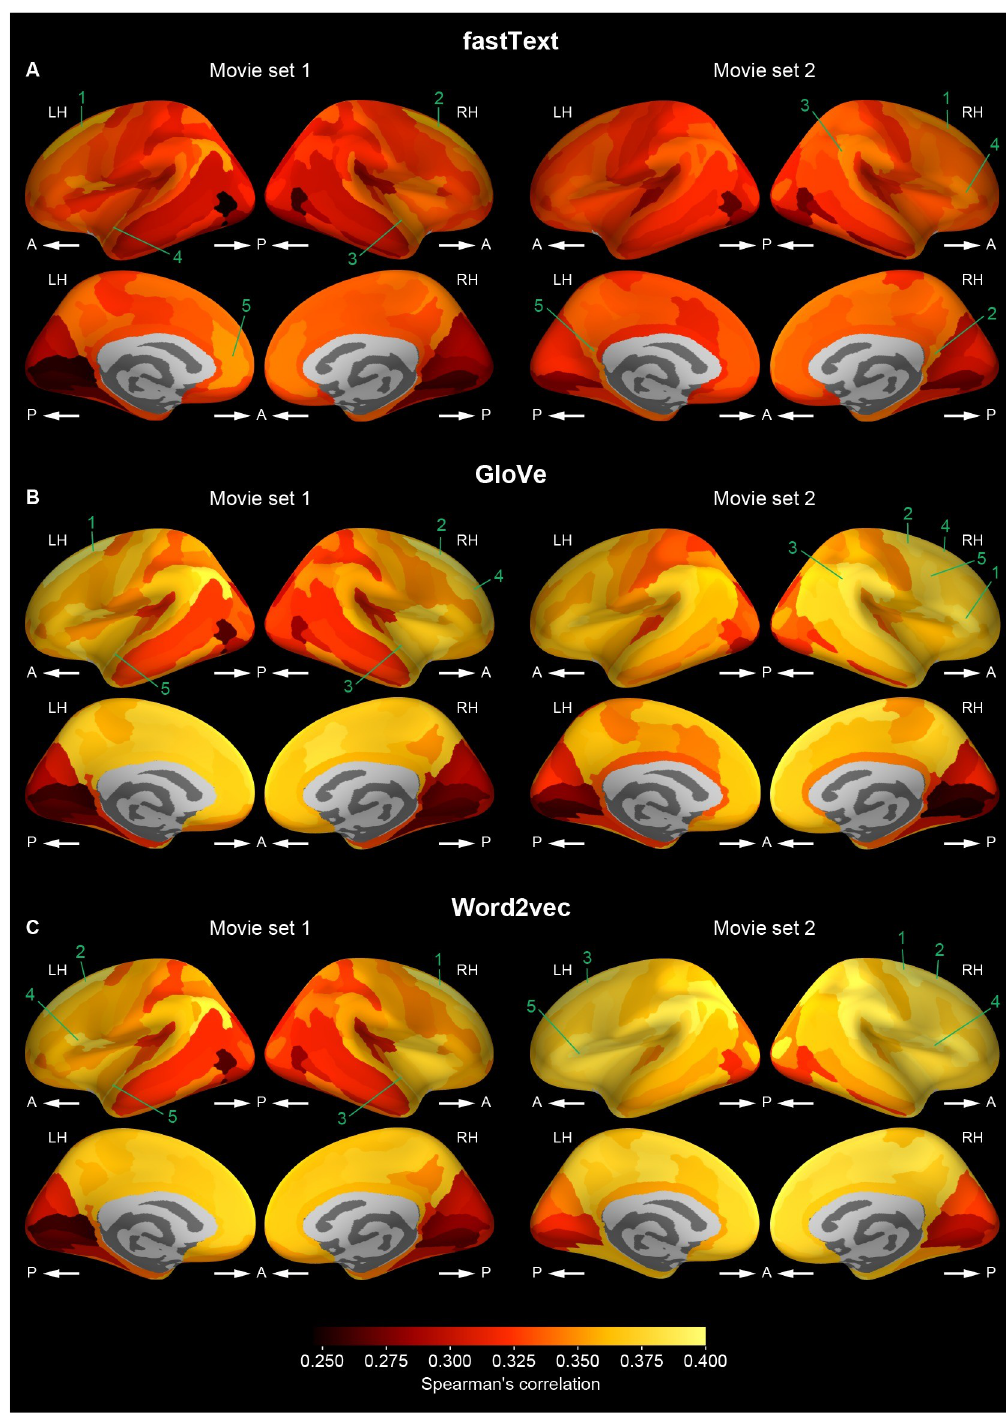
Fig 10. Cortical mapping of brain–behavior correlations of adjective dissimilarity. The same analysis as in Fig 9 but for adjective dissimilarity. The names of the five cortical regions with the highest Spearman’s correlation coefficients for each word-vector type and each movie set are shown in S16